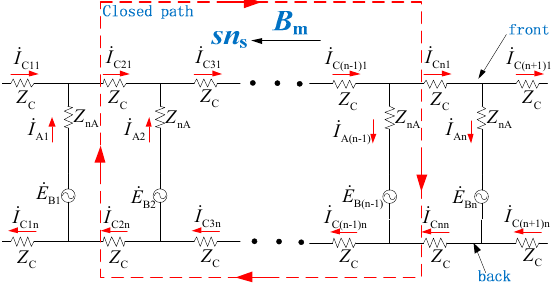
Figure 4. Simplified circuit diagram of SSR.